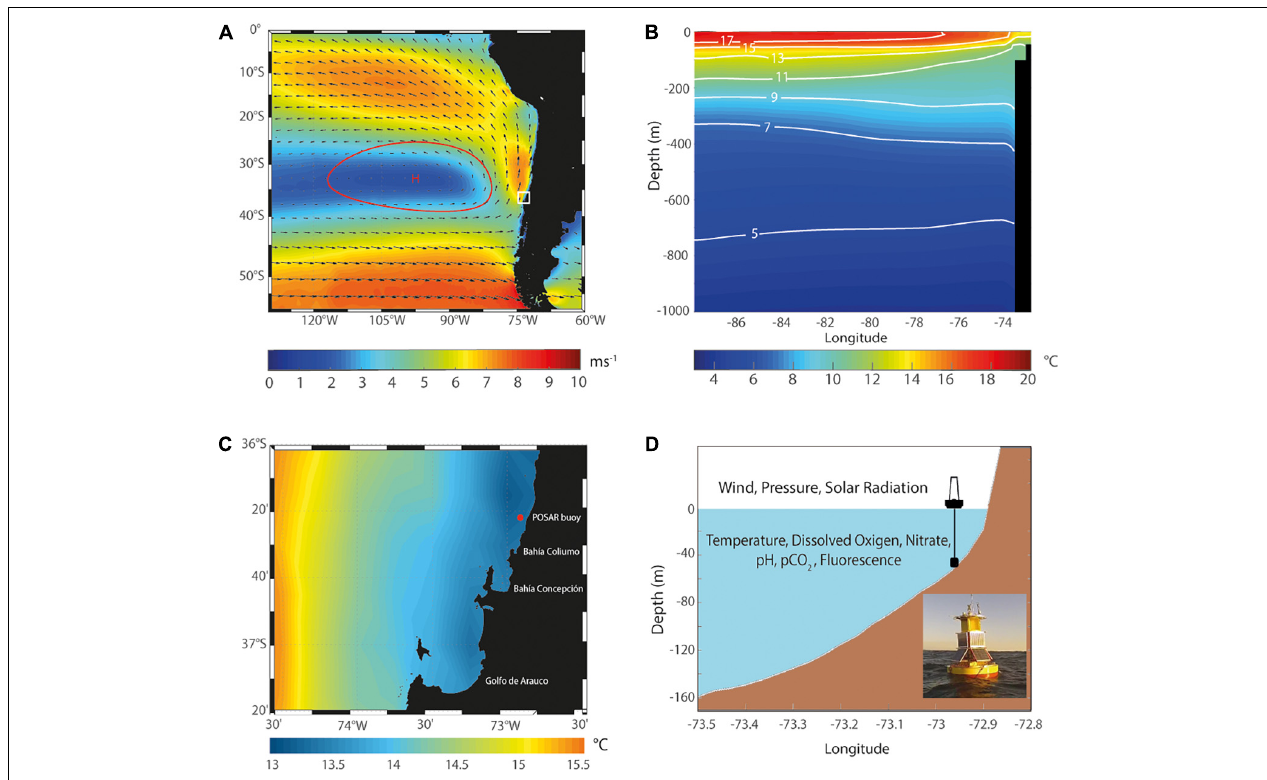
FIGURE 1 | (A) Mean magnitude (ms − 1 , colors) and direction (vectors) of 10-m winds in the Southeast Pacific during two consecutive summer seasons (2016–17 and 2017–18 years) from ERA5 reanalysis. The red contour and H represent the high-pressure Southeast Pacific Anticyclone (1020 hPa). The box indicates the region where the buoy POSAR is located. (B) cross-section of ocean temperature during November to April from the WOCE/Argo Global Hydrographic Climatology (WAGHC). (C) Sea surface temperature in the study area ( ◦ C, colors). The red dot indicates the position of the measurements recorded by the buoy POSAR. (D) Scheme (longitude/depth) of the local topography with the location of the buoy